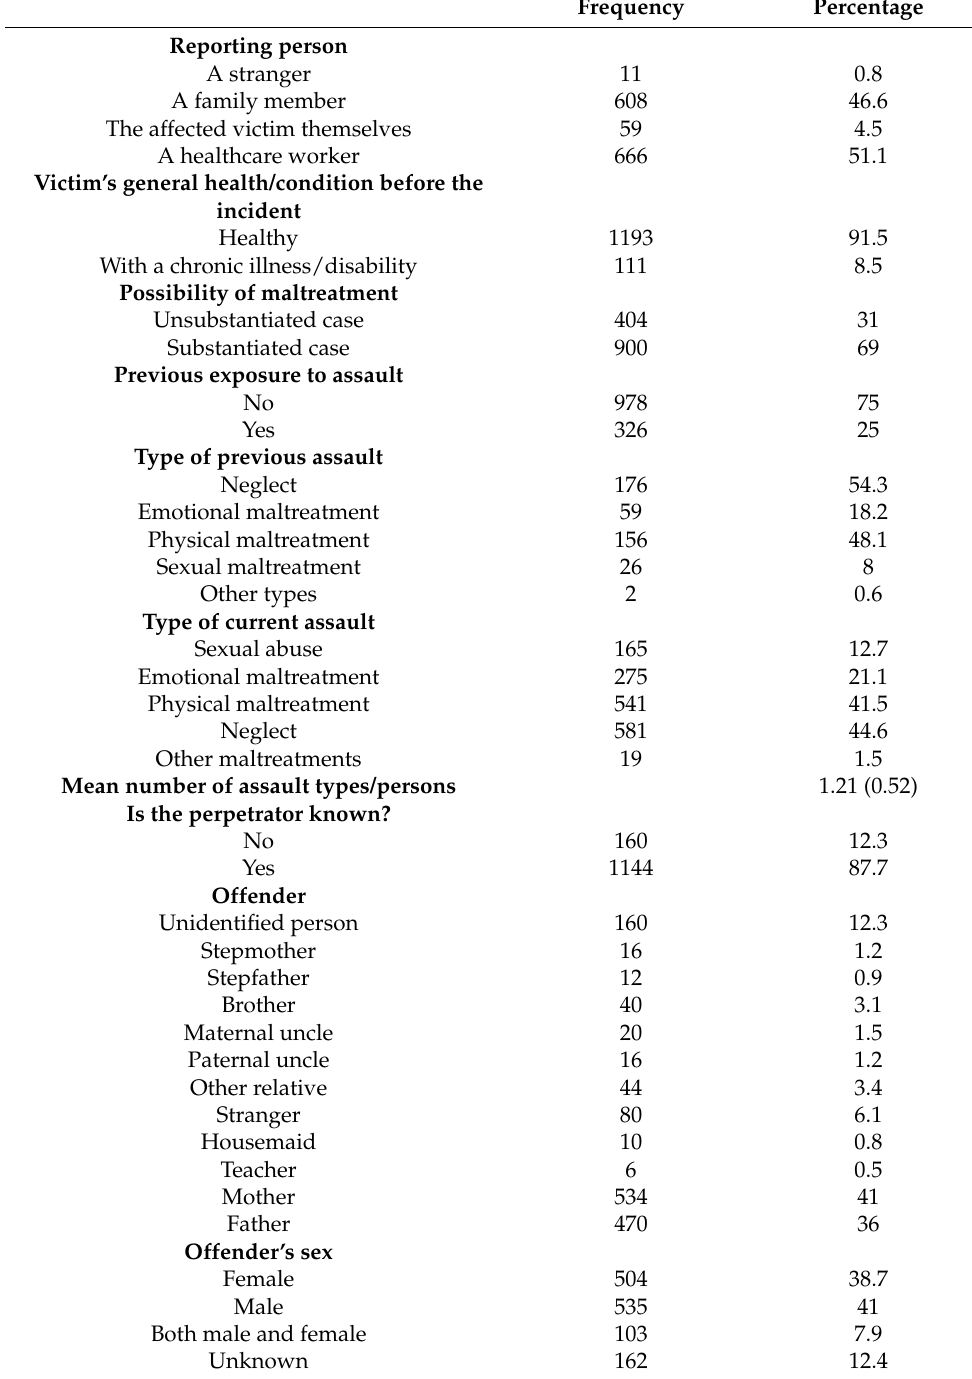
Table 2. Descriptive analysis of the measured assault types and offending